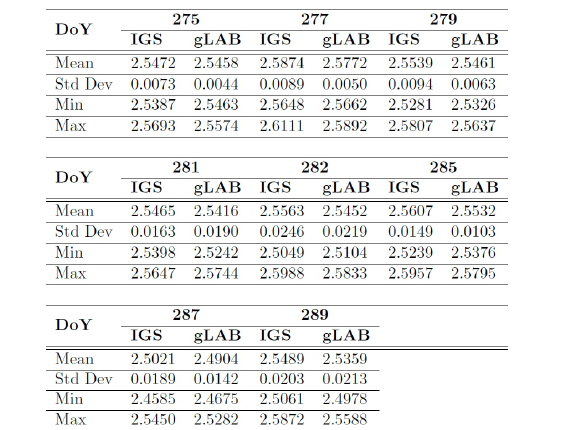
Table 2: Descriptive Statistics run on ZTD values from IGS